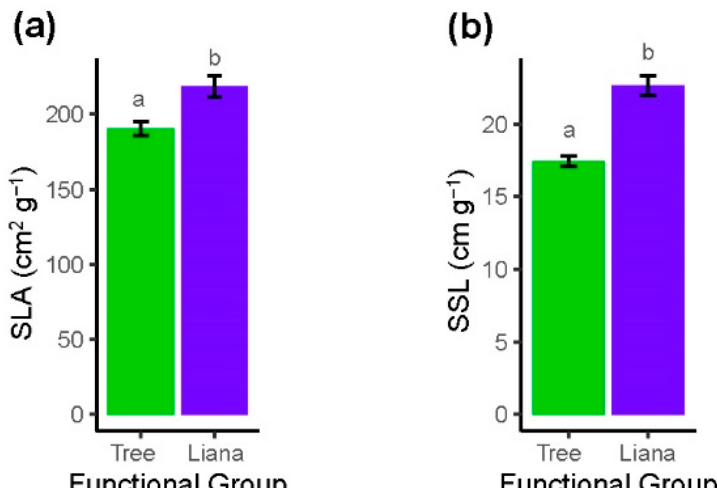
Figure 1. Trait averages of functional groups of lianas and trees. Bars represent marginal means and error bars show SE (95% confidence level) for ( a ) specific leaf area (SLA) and ( b ) specific stem length (SSL). Letters at the top of bars indicate significant ( p < 0.05) differences among different clusters based on Tukey’s HSD tests.